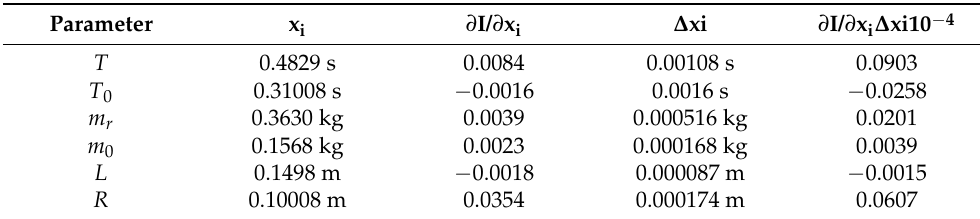
Table 4. Average values, partial derivation, standard deviation, and the influence of every parameter in error for the case of vertical rotation.